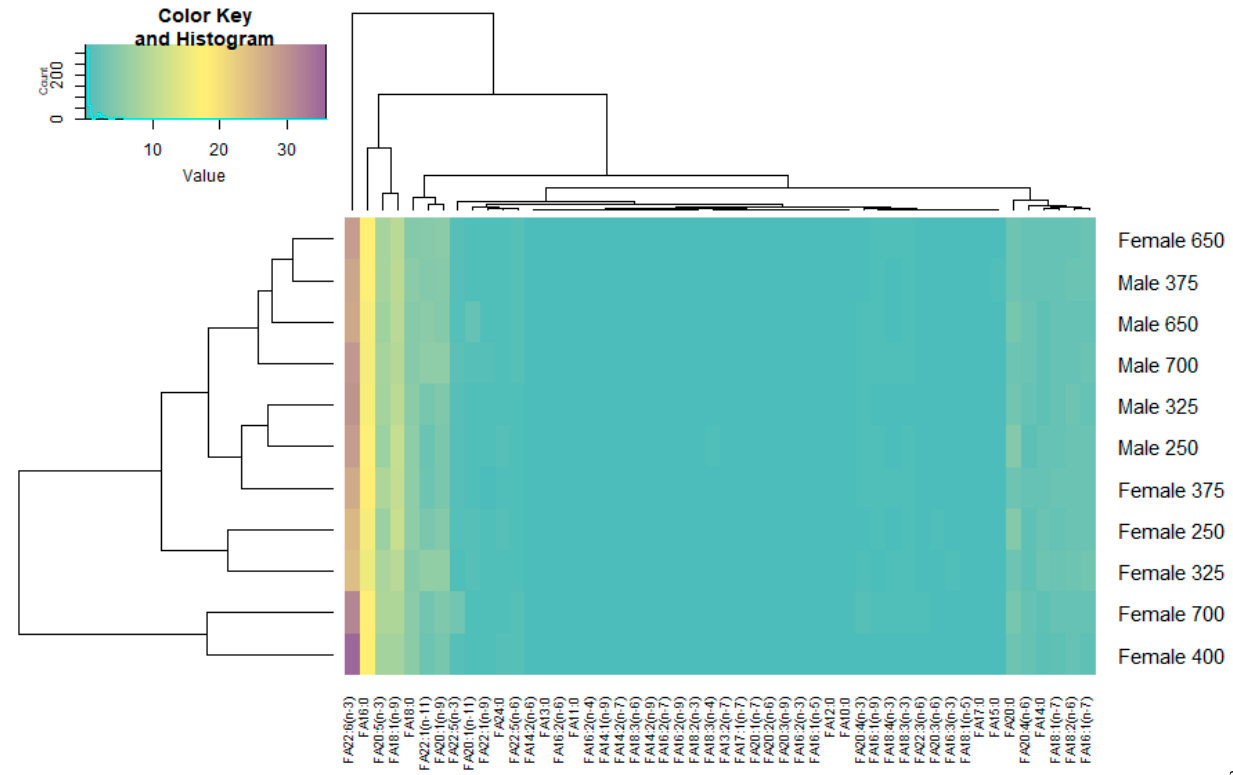
Figure 5. Heatmap of the qualitative and quantitative content of fatty acids (FAs) in the muscle tissue of male and female beaked 243 redfish, Sebastes mentella, at different depths of the Irminger Sea (North Atlantic). 244 The content of DHA in fish muscle tissue increased (no significant changes were 245 detected) depth-wise. The muscle n-6 PUFA content rose to 6% at some depths. The 246